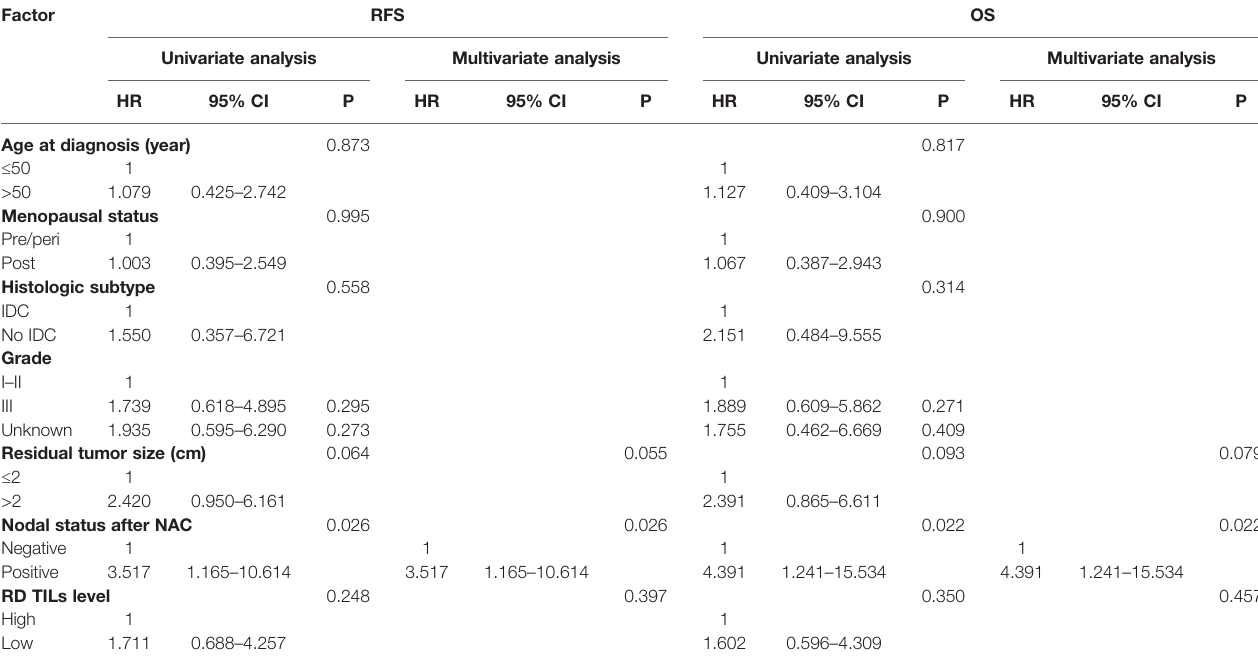
TABLE 6 | Univariate and multivariate analyses for RFS and OS in Ki67 decrease group. Factor